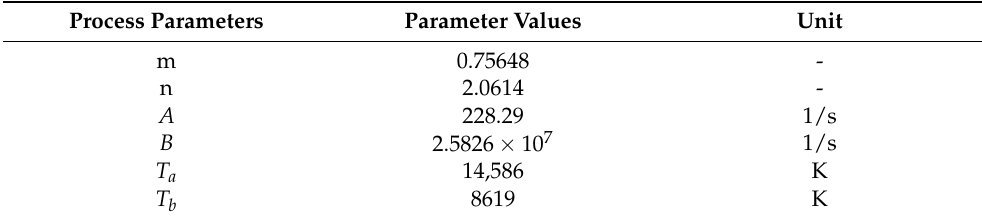
Table 2. Values of Kamal’s model constants. The constants were measured by a DSC. Process Parameters Parameter Values